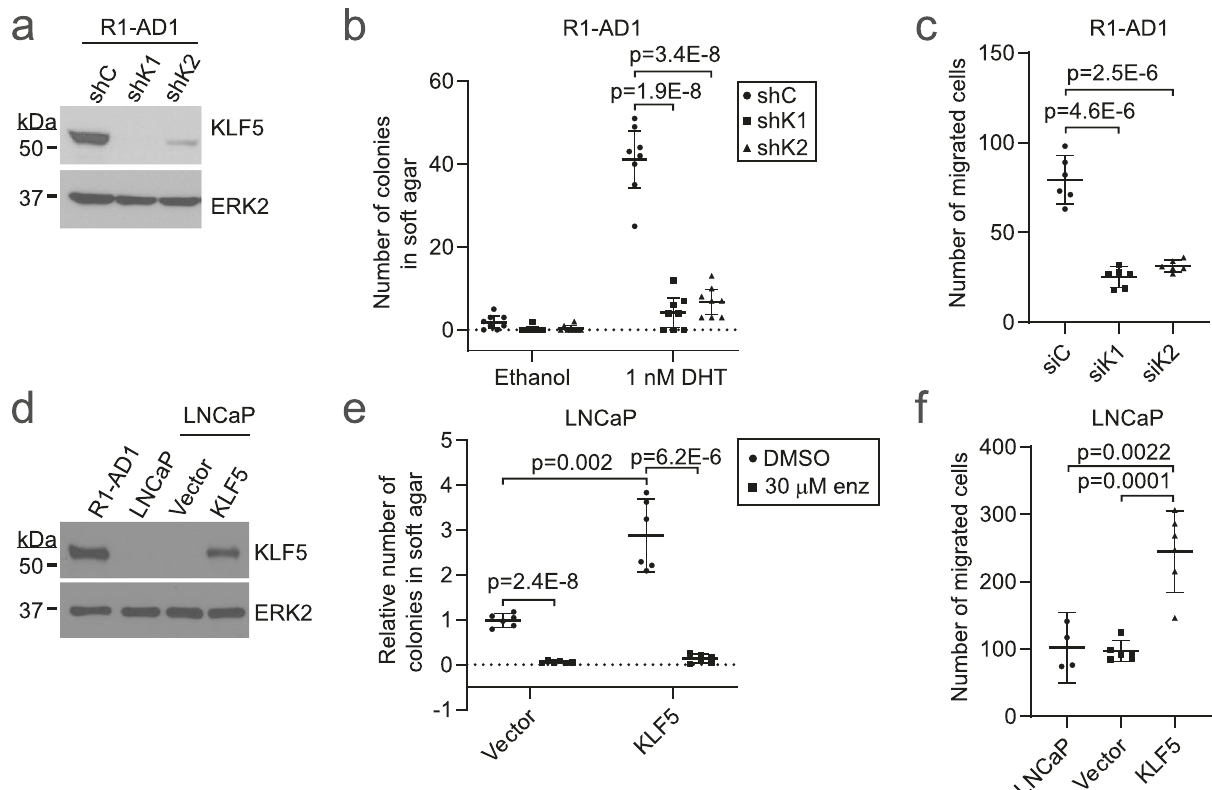
Fig. 4 KLF5 promotes oncogenic phenotypes in prostate cancer cells. a KLF5 protein measured by western blot using R1-AD1 cells infected with control shRNA lentivirus (shC) or two independent KLF5-targeted shRNA lentiviruses (shK1 and shK2). ERK2 is a loading control. b R1-AD1 cells as in a were analyzed by 3D soft agar colony formation assays in androgen-deplete medium supplemented with 1 nM DHT or vehicle control (0.1% ethanol). n = 8, mean ±95% CI from 2 independent experiments in biological quadruplicate ( n = 8). c R1-AD1 cells transfected with KLF5-targeted siRNAs (siK1 and siK2) or control siRNA (siC) were analyzed by chemotactic migration assays. n = 6, mean ±95% CI, 2 independent experiments in biological triplicate. d KLF5 protein measured by western blot using R1-AD1 cells, LNCaP cells, and LNCaP cells infected with empty lentivirus or lentivirus encoding KLF5. ERK2 is a loading control. e LNCaP cells as in d were analyzed by 3D soft agar colony formation assays in an androgen-replete medium supplemented with enzalutamide or vehicle control (DMSO). n = 6, mean ±95% CI, 2 independent experiments in biological triplicate. f LNCaP cells as in d were analyzed by chemotactic migration assays. n = 4 or 6, mean ±95% CI, 2 independent experiments in biological duplicate or triplicate. P -values are from 2-sided, 2-tailed t